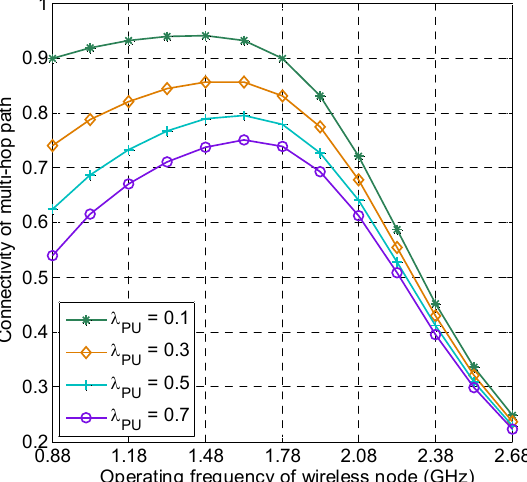
Figure 12 . The connectivity of multi-hop path in CRAHNs with different average active rates of PU; network size = 2000 m × 2000 m, number of SUs = 100, number of PUs = 3, one frequency layer with operating frequency = 0.88 GHz ~ 2.68